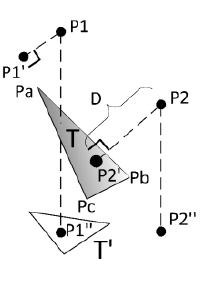
Figure 7 - Point in 3D triangle, and point to plane distance